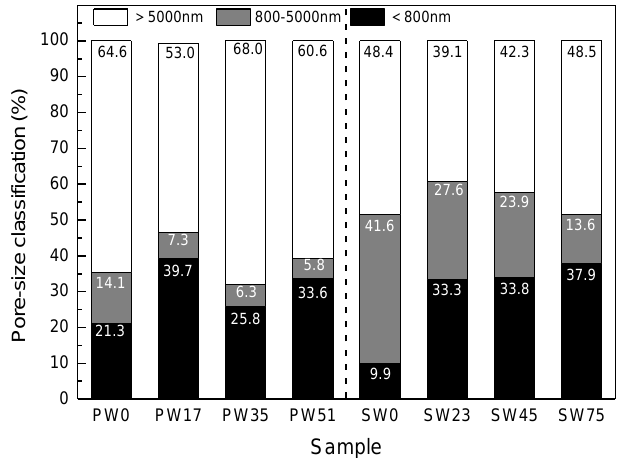
Figure 2. Comparison of the average pore size classification of untreated and furfurylated Chinese fir and poplar wood.